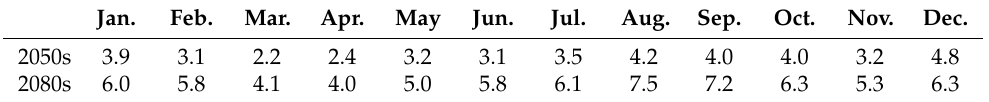
Table 1. Monthly mean values ( µ ) of outdoor air temperature changes obtained from [24].